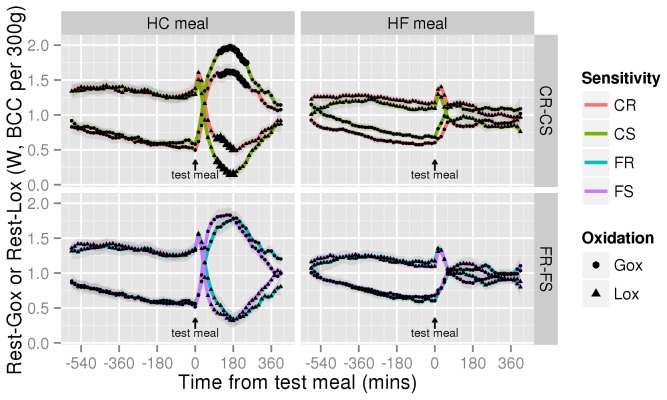
Differences in Rest-Gox and Rest-Lox between CR and CS or FR and FS animals.Rest-Gox (circles) and Rest-Lox (triangles) profiles during HC and HF meal fasting-refeeding procedures between CR (red n=12) and CS (green n=12) or FR (blue n=12) and FS (purple n=12) rats are computed in Watts from resting VO2 and VCO2 according to the following formulae [10]: Gox=((4.57×VCO2)-(3.23×VO2))×15.6)/60, Lox=((1.69×VO2)-(1.69×VCO2))×39.5)/60, with VO2 and VCO2 in ml/min, 15.6 = kJ/g for glucose, 39.5 = kJ/g for lipids. Division by 60 is to convert Joules per minutes into Joules per second = Watts. BCC = body composition corrected. The underlying data is the same as that for Rest-RQ and REE described in Figure S5, averaged across CS and CR or FR and FS rats. Shaded areas are the group SEM. The meal was given at time=0. The only situation where significant differences appeared was the CR–CS comparison during a HC meal, indicated by the larger circles and triangles (pairwise per-timepoint t-tests P<0.01; for Rest-Gox between 120 and 240 mins, for Rest-Lox between 105 and 180 mins inclusive).